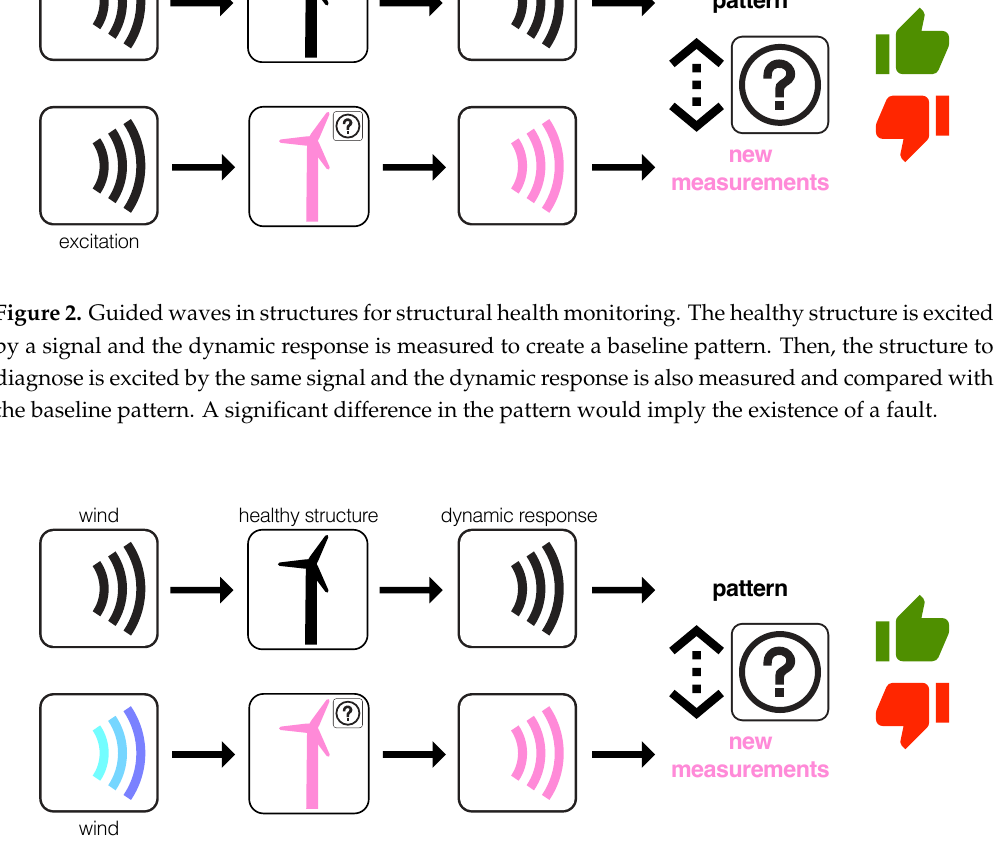
Figure 3. Even with a different wind turbulence, the fault detection strategy is able to detect some damage, fault or